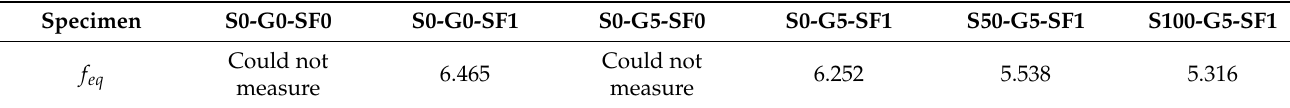
Table 8. Results of the equivalent flexural strength.